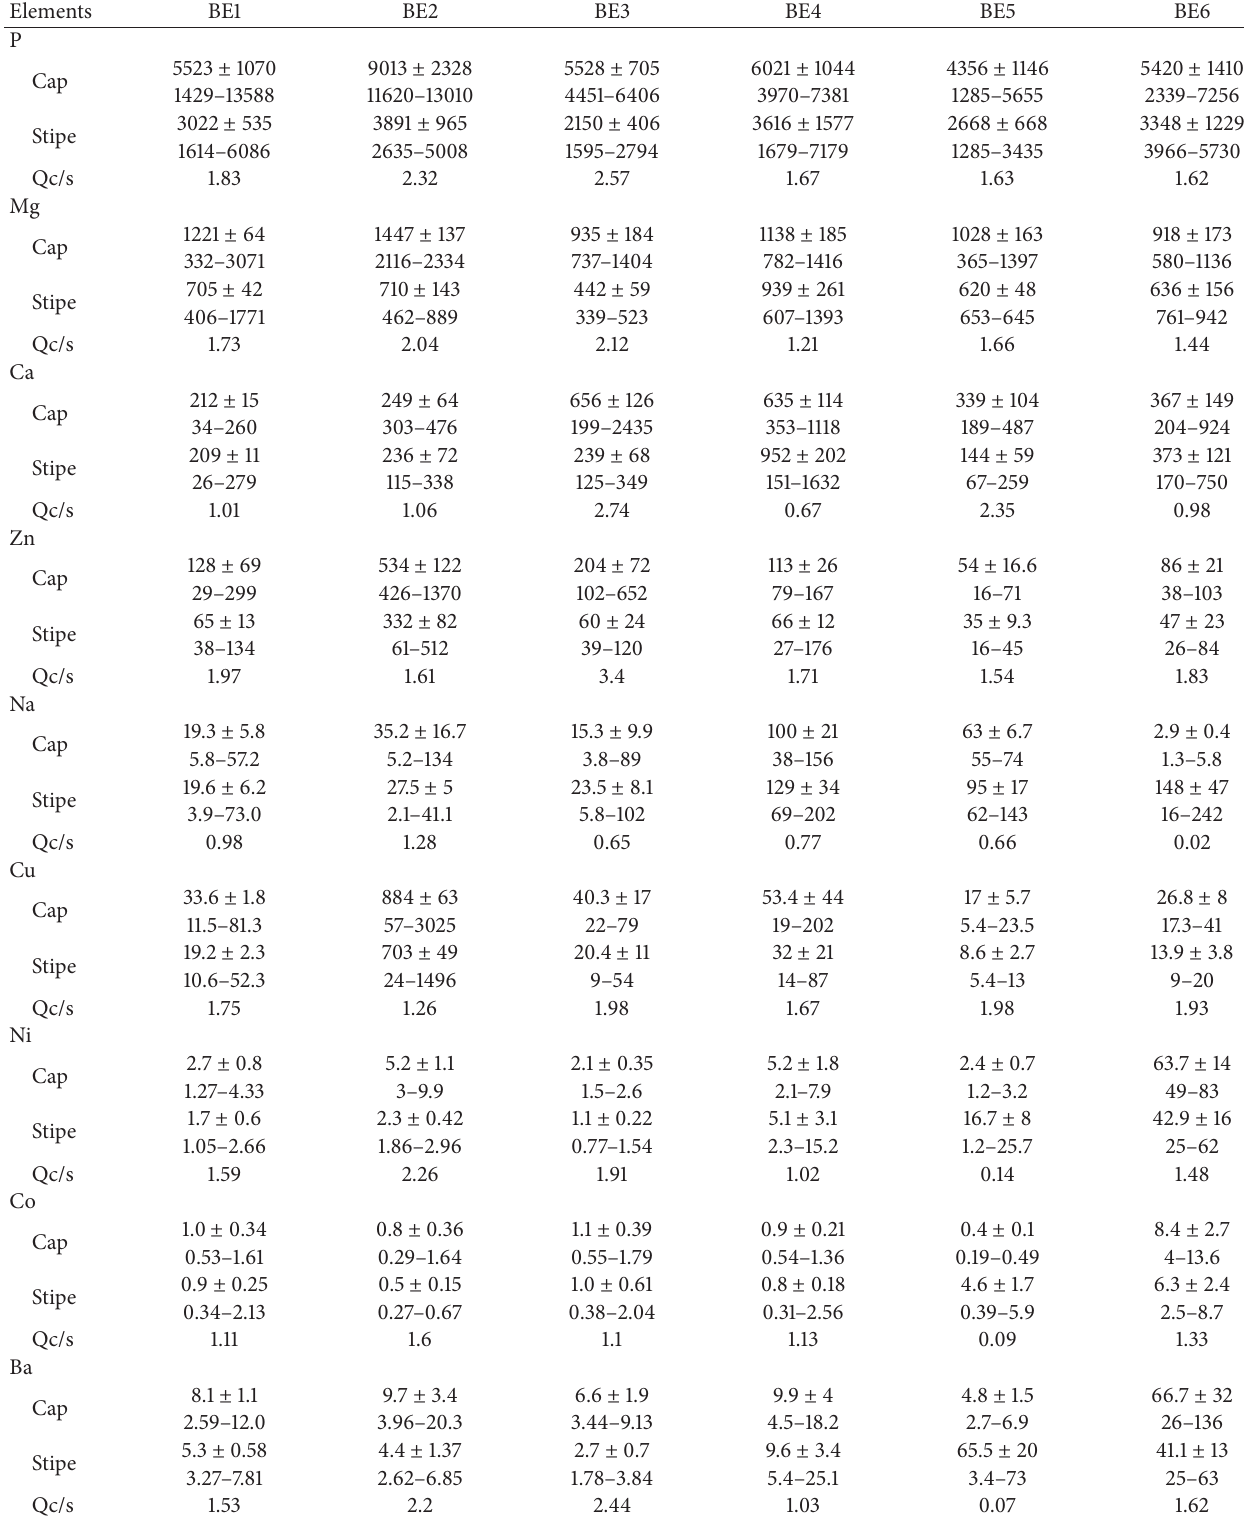
Table 2: Elements content of Boletus edulis collected from central part of Yunnan province in 2011 (mg/kgdm, mean, SD,